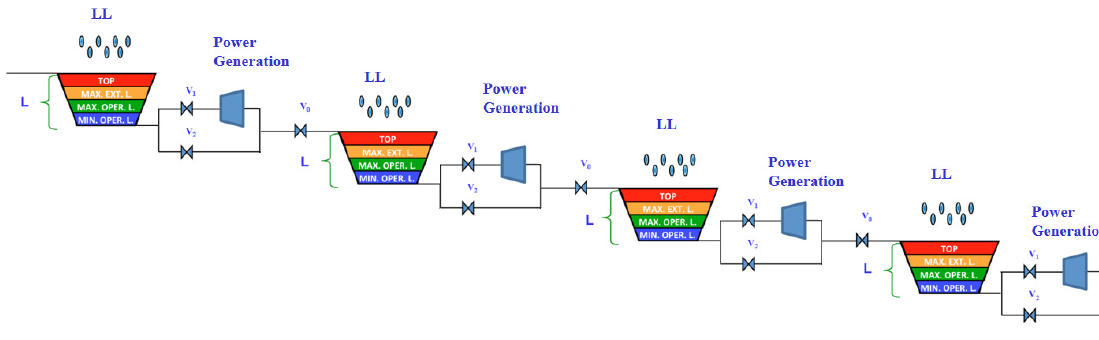
Figure 2. Multiple dam